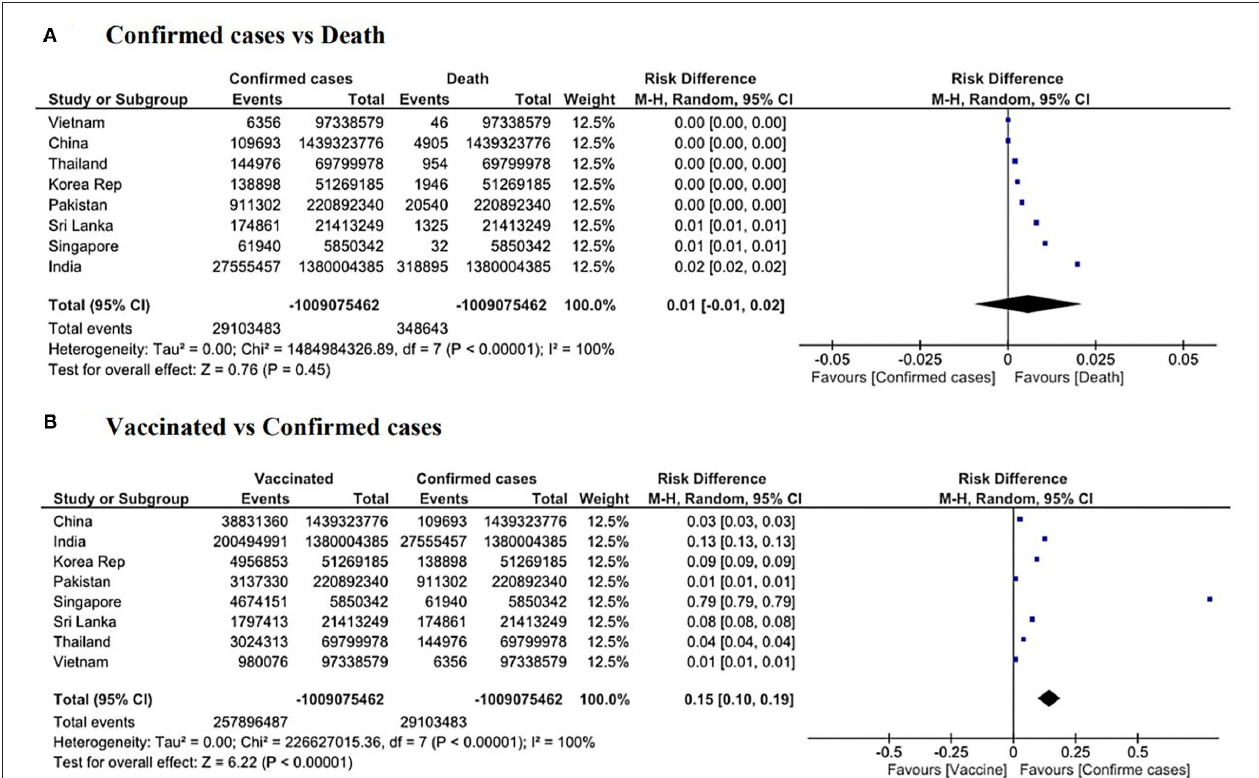
FIGURE 4 | Meta-analysis of COVID-19 outcome in PSI implemented countries. Forest plots showing (A) Total confirmed cases vs. total number of death due to COVID-19. There is significant overall higher death in this cohort, (B) Overall significant number of confirmed cases when compared to vaccinated population in PSI implemented Asian